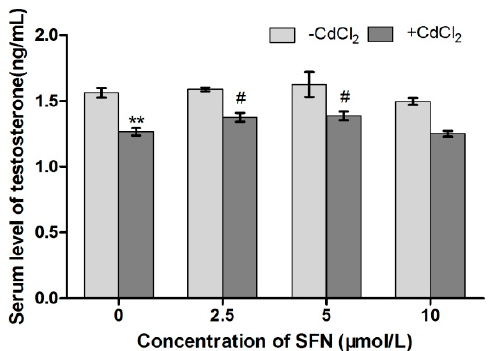
Figure 5. Secretion levels of testosterone in TM3 cells. * and ** represent a significant and extremely significant difference, respectively, compared with the control group. # represents a significant difference, compared with the Cd group.